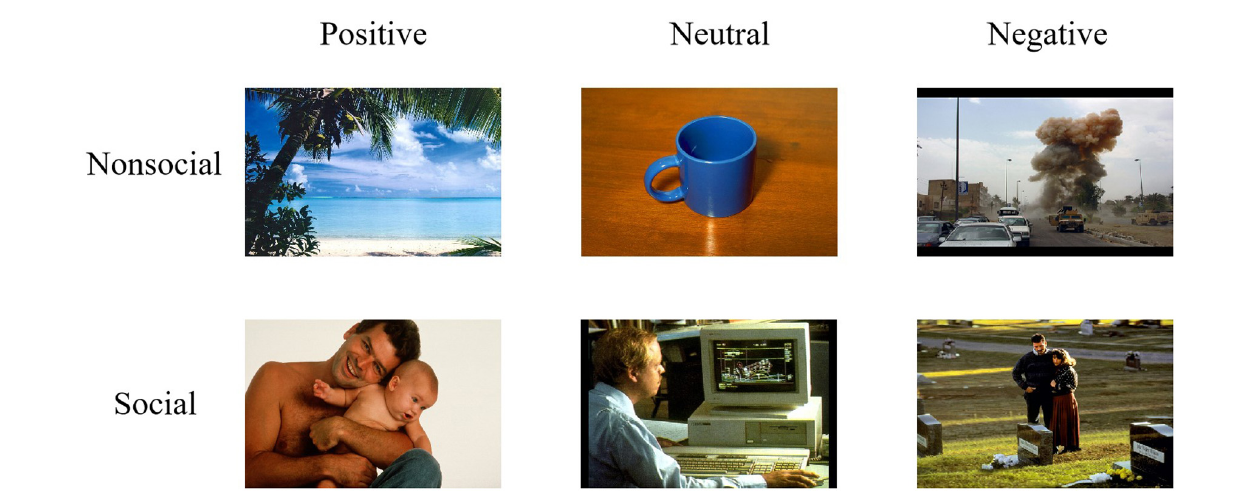
FIGURE 1 | Examples of pictures used in Experiment 1. Examples of nonsocial (top panel) and social (bottom panel) pictures with positive (left column), neutral (middle column), and negative (right column) emotional valence. Pictures were selected from the International Affective Picture System (IAPS) (Lang et al., 2005) (Reproduced with permission from Di Yang), and the Chinese Affective Picture System (CAPS) (Reproduced with permission from Di Yang and Yuanyan